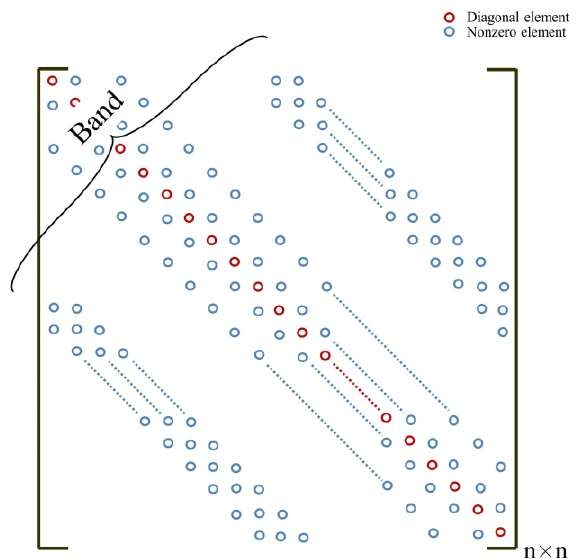
Figure 4. General form diagram of the coefficient matrix.